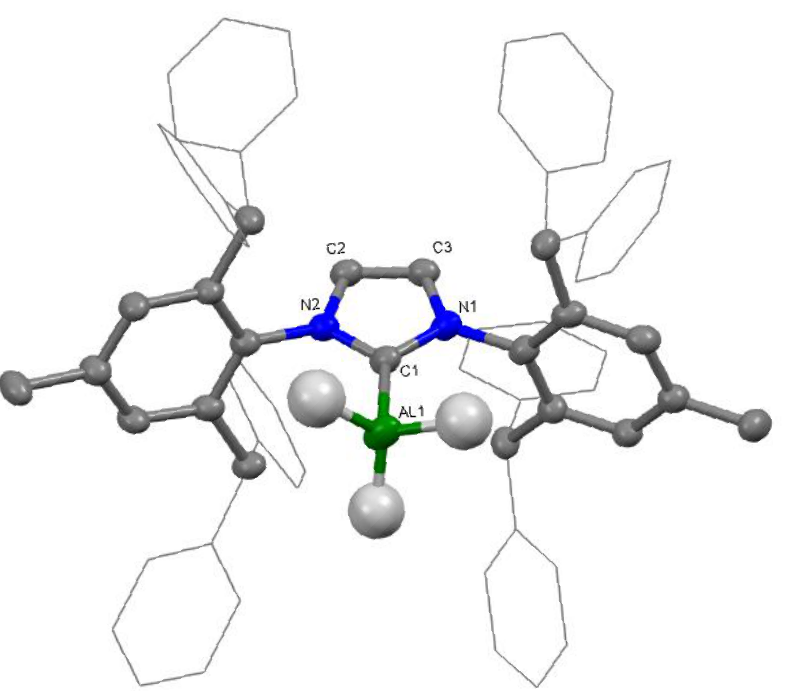
Figure 3. Solid-state structure of IPr*AlH 3 ( 1 ) with ellipsoids drawn at 50% probability, peripheral phenyl rings have been depicted in wireframe for clarity. Solvent and hydrogen atoms other than those on aluminium have been omitted for clarity. Selected bond lengths (Å ) and angles (°): Al(1)-C(1) 2.070(2), C(1)-N(1) 1.357(3) C(1)-N(2) 1.369(3), C(2)-C(3) 1.342(3), Average Al-H 1.54, N(1)-C(1)-N(2) 104.09(18).